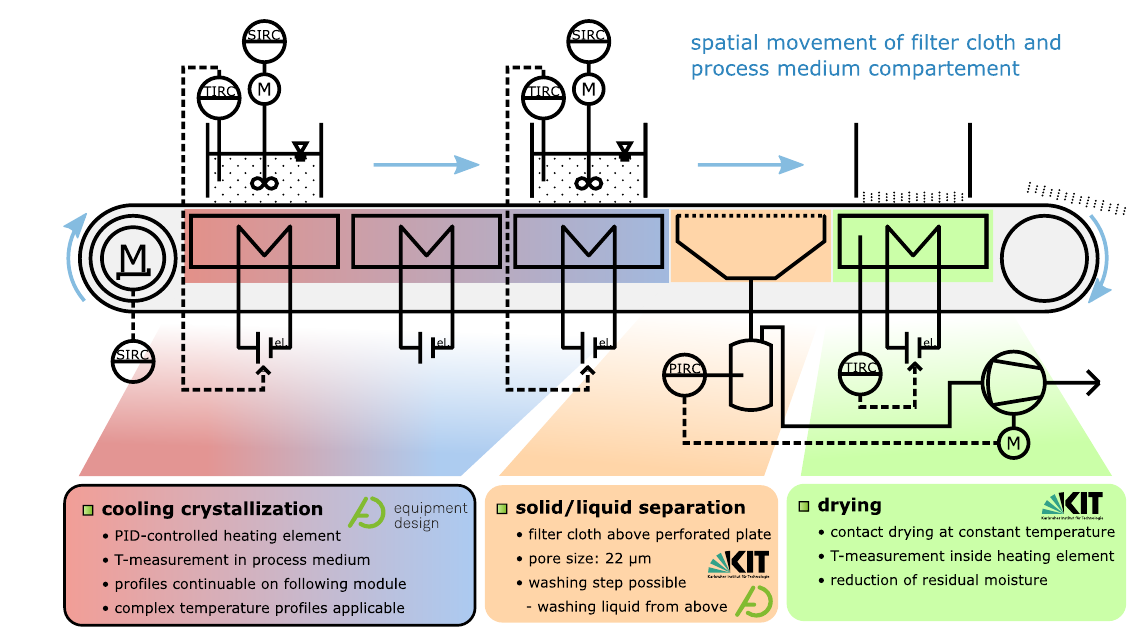
Figure 1. Simplified Piping and Instrumentation Diagram of the quasi-continuous filter belt crystal- lizer. Process containers are incrementally moved from left to right, passing each